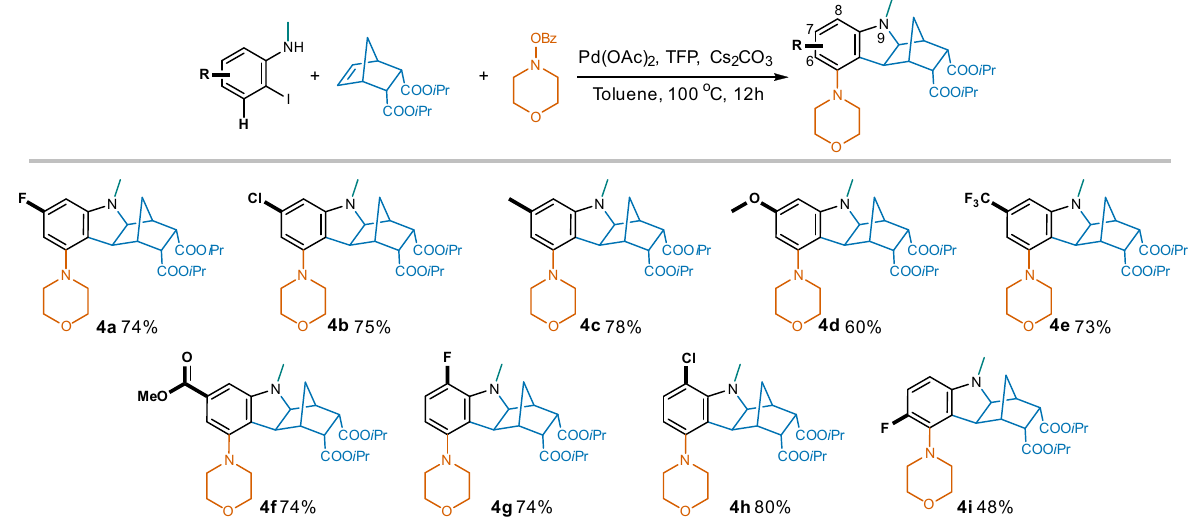
Fig. 6 Compatibility of substituents on 2-iodo- N -methylaniline. Reaction conditions: substituted 2-iodo- N -methylaniline (1.0 eq.), NBE-5,6-diCOO i Pr (1.0 eq.), morpholino benzoate (1.3 eq.), Pd(OAc) 2 (5% eq.), TFP (10% eq.), Cs 2 CO 3 (2.5 eq.), toluene, 100 o C, 12 h.